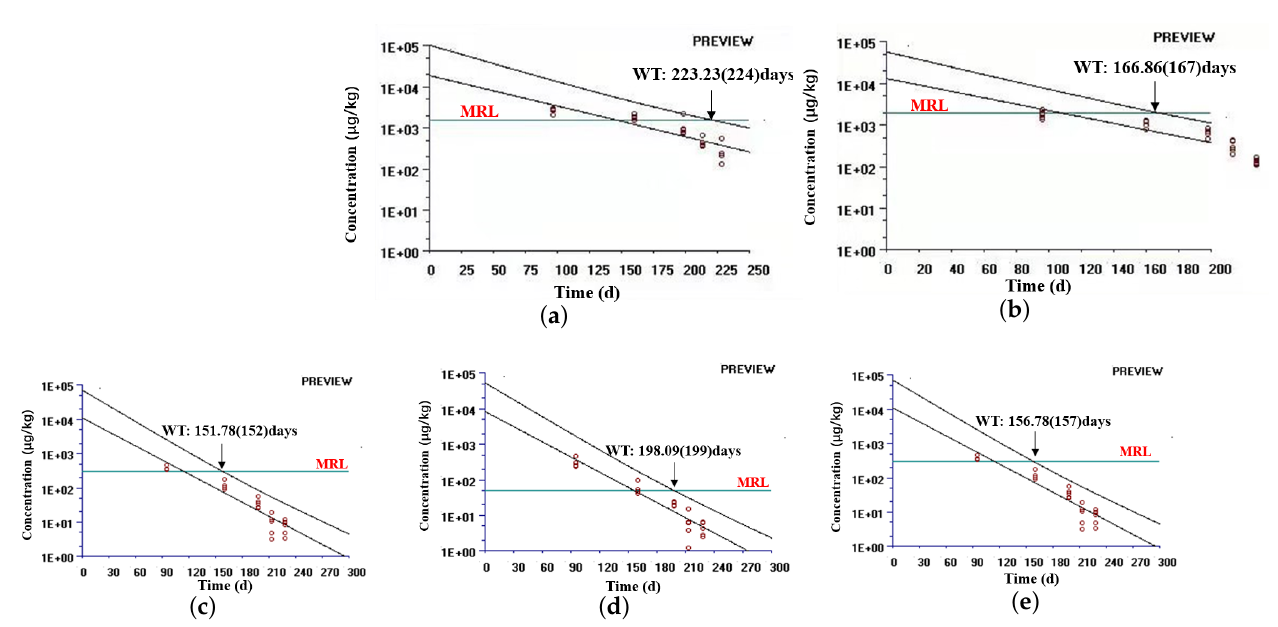
Figure 4. Estimated withdrawal times for IMD in bovine tissues: ( a ) for the liver, ( b ) for the kidney, ( c ) for muscle, ( d ) for fat, and ( e ) for the injection